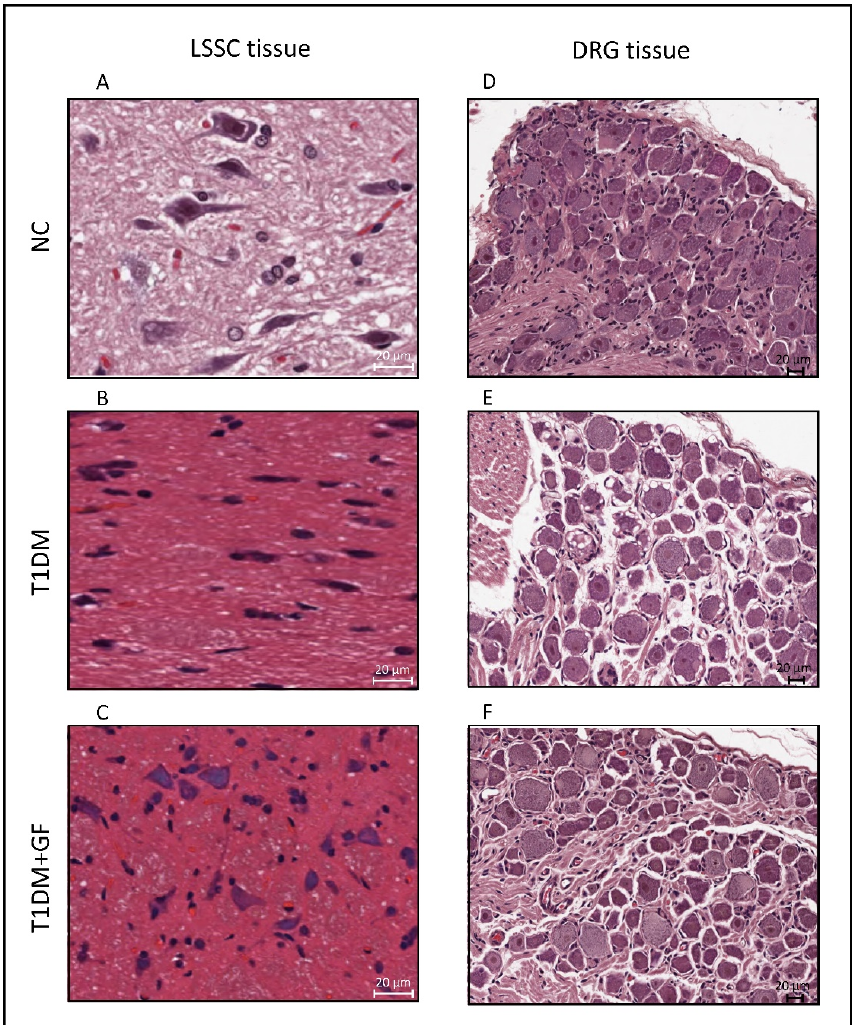
Figure 4. Chronically administered guanfacine halts diabetes-induced neuronal degeneration. Guanfacine (0.6 mg/Kg) was administered intraperitoneally daily for a period of two weeks. Hematoxylin and Eosin staining of LSSC ( A – C ) and DRG ( D – F ), respectively (magnification: 40× and scale bar: 20 µ m). Abbreviations: NC, Normal Control; T1DM, Type 1 Diabetes Mellitus; GF, guanfacine; LSSC, lumbar segment of the spinal cord; and DRG, dorsal root